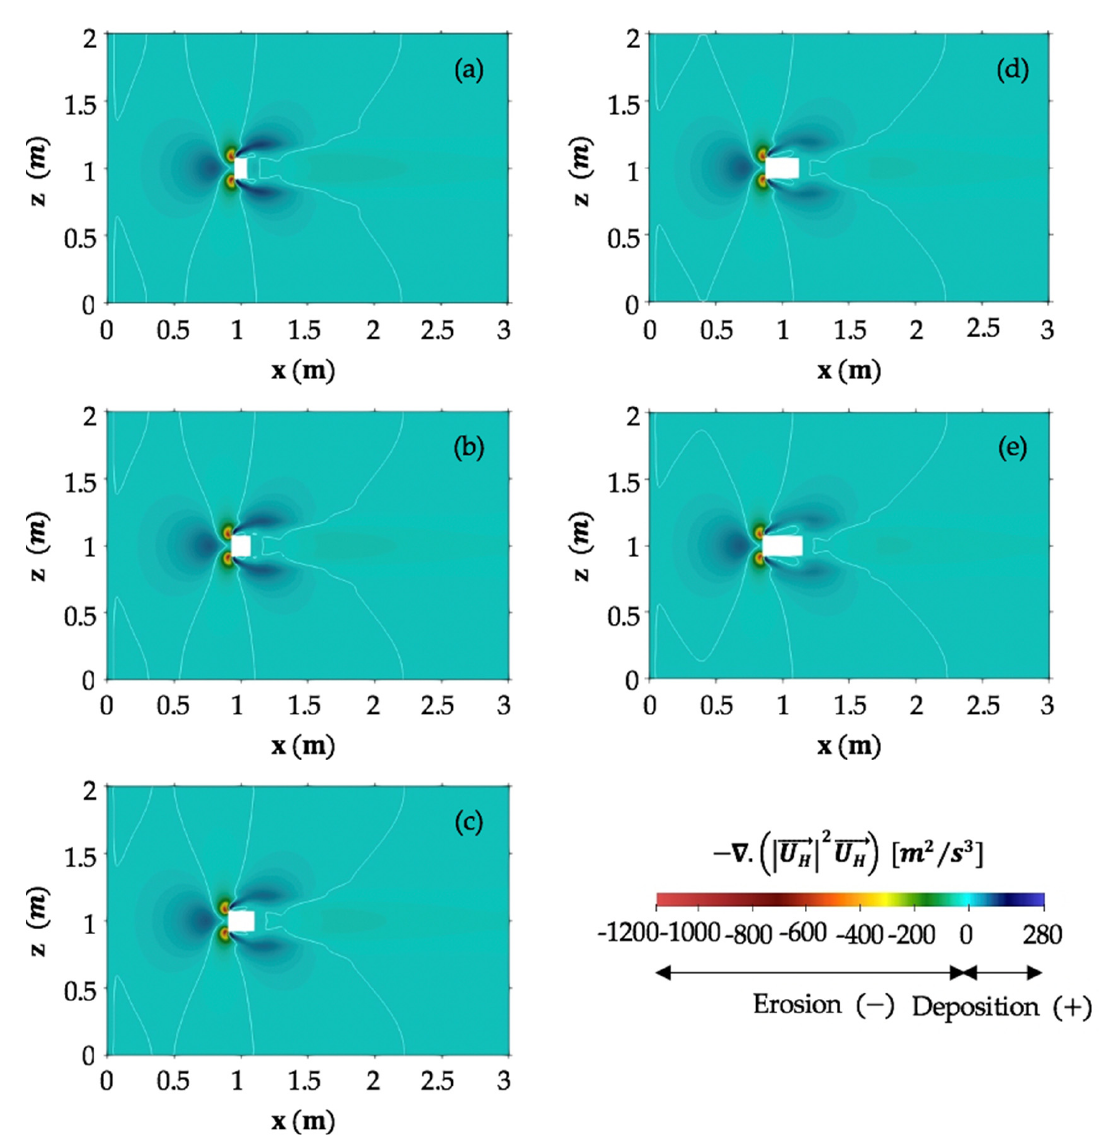
Figure 10. The impact of building length on erosion and deposition patterns inferred from the convergence of the third-order horizontal wind velocity field at a near-surface plane, y = 0.0125 m. The building width and height are w (cid:48)(cid:48) and h (cid:48)(cid:48) , respectively. The building length, l (cid:48)(cid:48) , is varied as ( a ) l (cid:48)(cid:48) ( b ) 1.5 l (cid:48)(cid:48) , ( c ) 2 l (cid:48)(cid:48) , ( d ) 2.5 l (cid:48)(cid:48) , and ( e ) 3 l (cid:48)(cid:48) 0 0 0 0